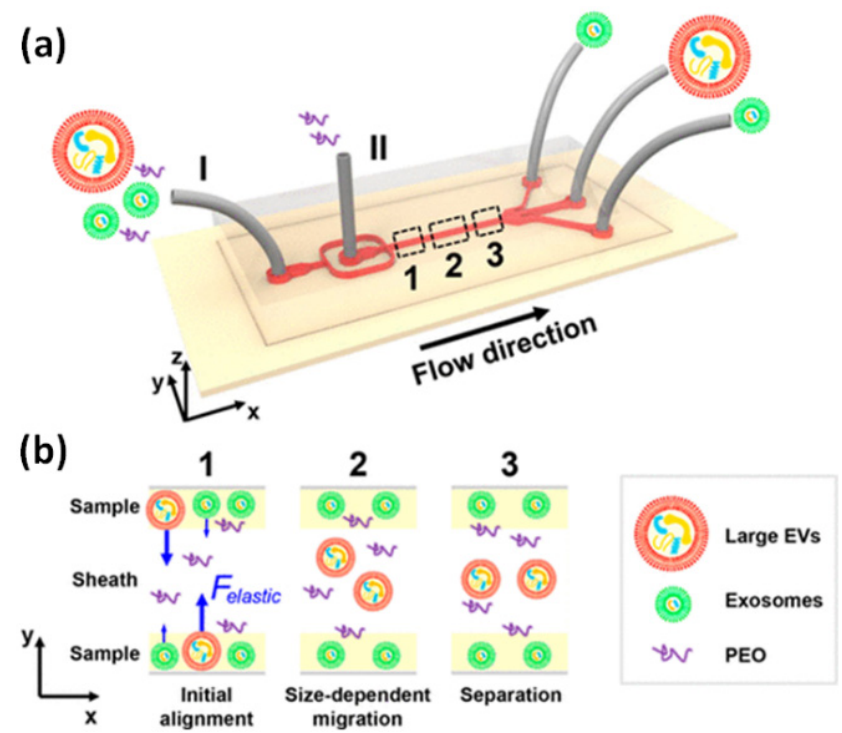
Figure 6. ( a ) Schematic of the microfluidic chip used by Liu et al. [102] for exosome separation from large EVs. The chip consists of two inlets and three outlets where EVs are collected in the center outlet while exosomes exit the two peripheral outlets. ( b ) Illustration of exosome isolation in a viscoelastic medium via elastic lift force (blue arrows) to migrate larger EVs toward the center of the channel while maintaining lateral exosome flow along the side walls of the device. Reprinted with permission from Lui et al. [102] . Copyright 2017 American Chemical Society.